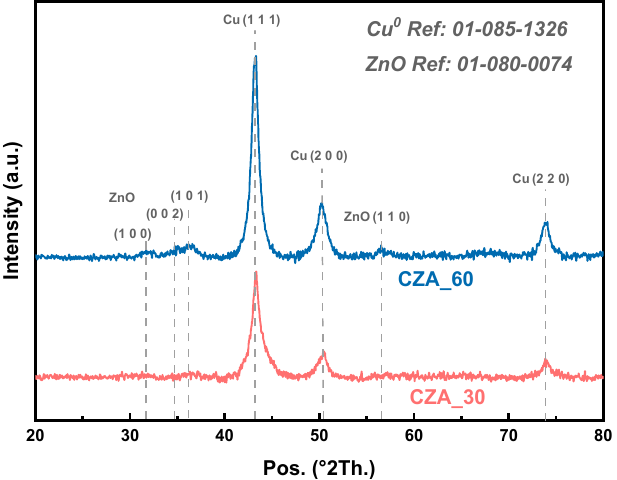
Figure 2. X-ray diffractograms of the reduced catalysts. Catalysts were reduced in situ under an H 2 flow at 250 °C (2 °C/min).